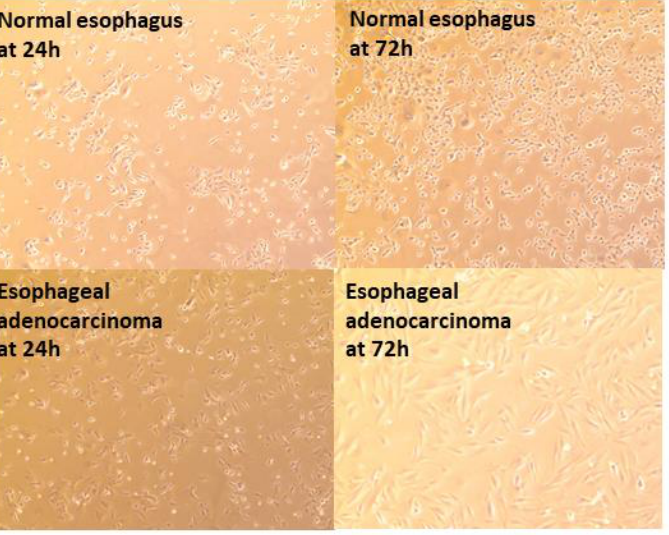
Figure 1. Normal esophagus and adenocarcinoma immortalized cell lines following thawing from liquid nitrogen at 24 and 72 h. Each image shows 4× magnification.